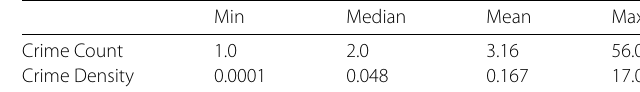
Table 3 Summary of crime count and density per street segment